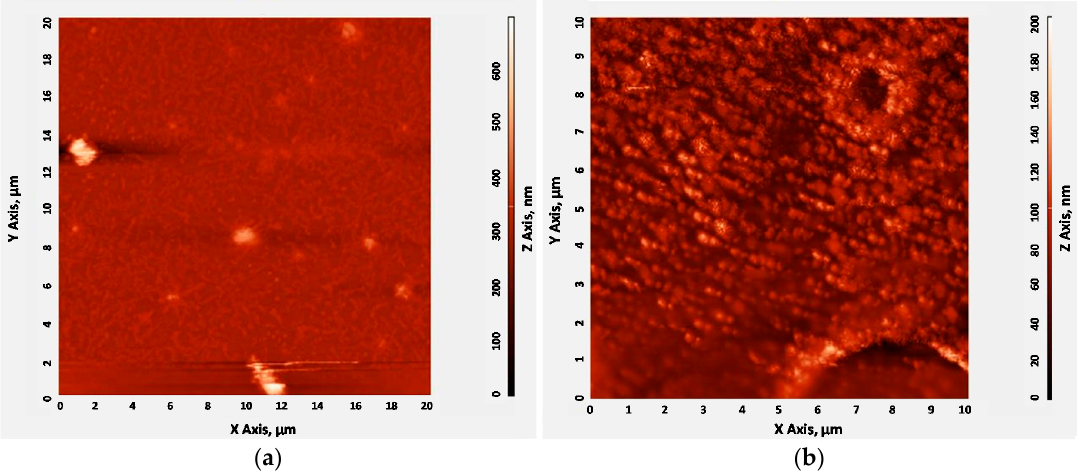
Figure 6. AFM characterization of CrypA coated by ( a ) Spin-coating; ( b ) Drop-coating.